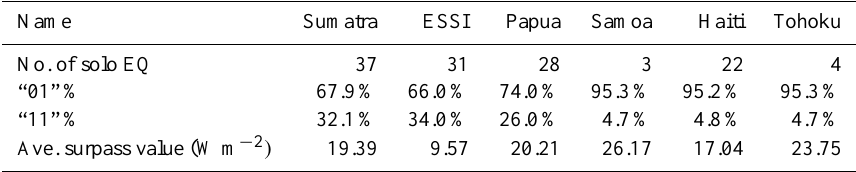
Table 5. Probabilities of “01” and “11” after declustering.